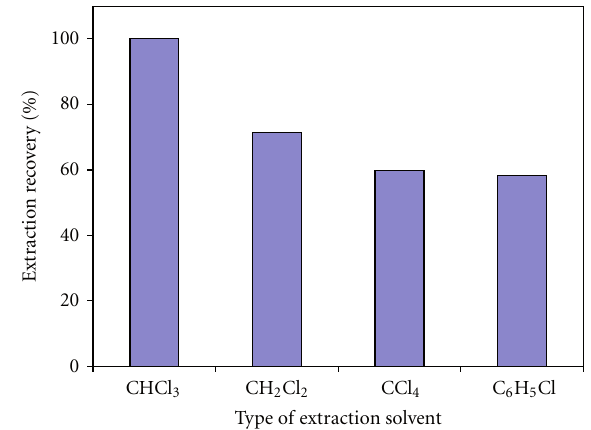
F 3: Effect of type of the extraction solvent on the extraction recovery of copper. Extraction conditions: water sample volume, 5.0mL; pH = 6; DPC concentration,